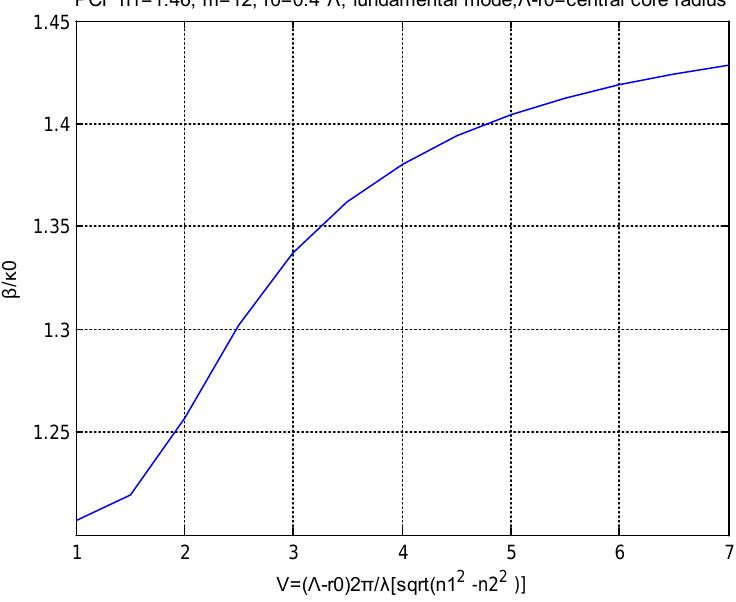
Figure 10. Average electric field of the even fundamental mode along the radial distance of the PCF.